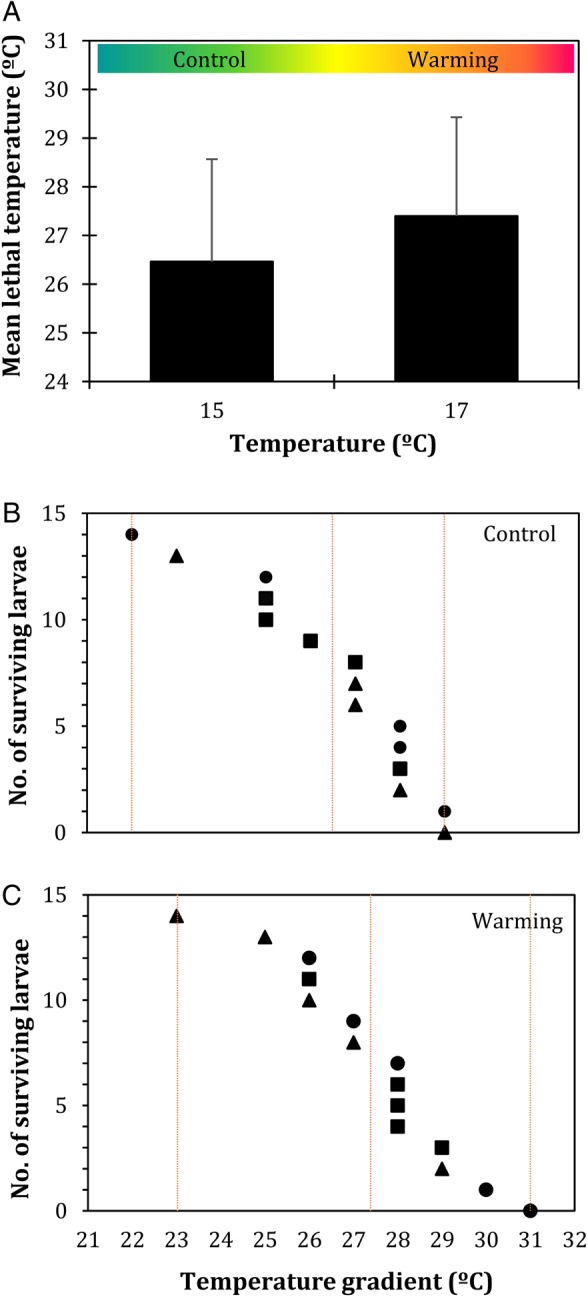
Impact of warming on the thermal tolerance of Sardina pilchardus larvae. (A) Mean lethal temperature of 30-day-old larvae in different thermal scenarios. Values represent means + SD (n = 3). (B and C) Number of surviving larvae from the control temperature and warming conditions, respectively, after exposure to an increasing temperature gradient. Different symbols represent different replicates. Vertical lines indicate the temperature at which larvae start dying, the mean lethal temperature and the temperature at which larvae stop dying. No significant differences were found between thermal treatments (P > 0.05).